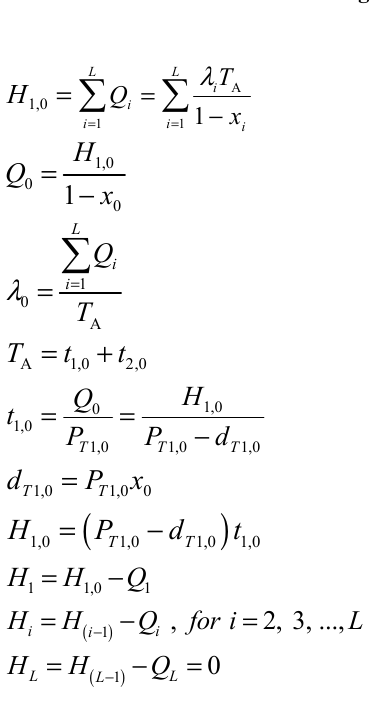
Fig. 2. Level of scrap stock in the studied